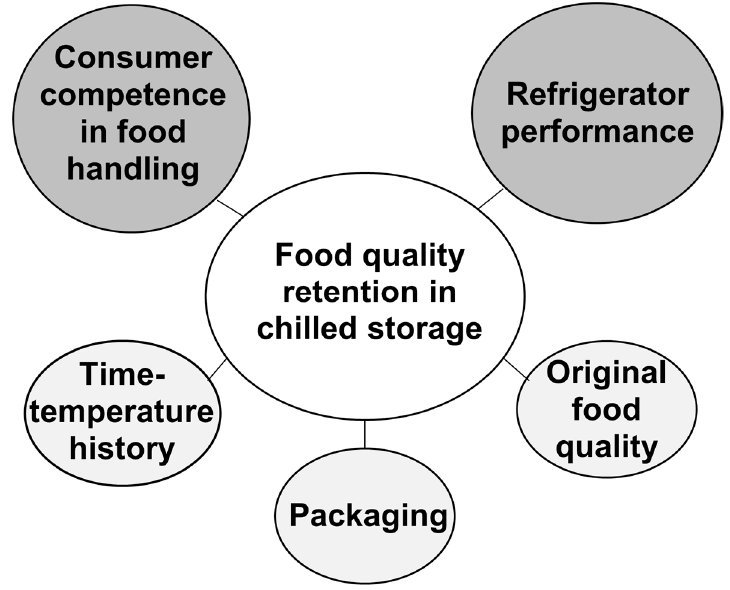
Figure 1. Parameters and their impact on defining food quality retention in chilled storage (own figure; study-focus topics are highlighted in grey).